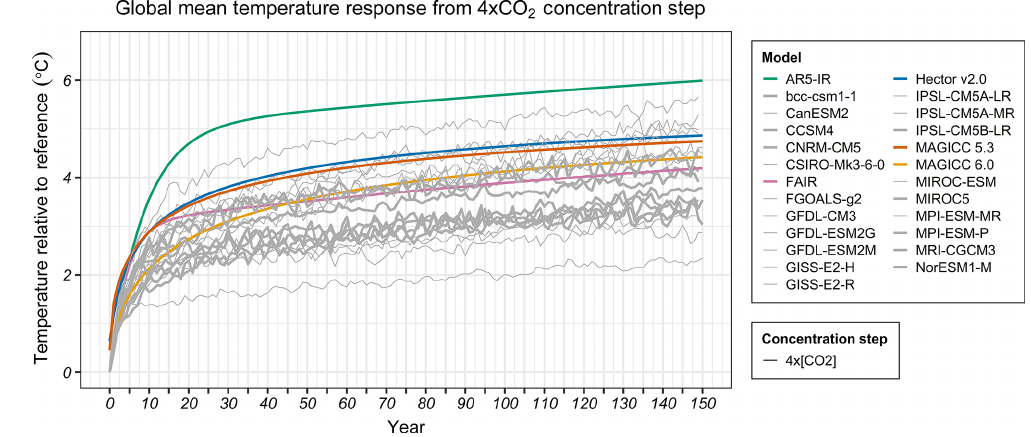
Figure 4. Global mean temperature response from 4 × CO 2 concentration step in CMIP5 models (grey) and SCMs (MAGICC 6.0 – yellow, MAGICC 5.3 BC–OC – red, Hector v2.0 – blue, FAIR – pink, AR5-IR – green). A climate sensitivity value of 3 ◦ C was used in the comprehensive SCMs, while in the idealized SCMs the parameter is not adjustable (see Sect. S2). The thick lines represent CMIP5 models with an ECS between 2.5 and 3.5 ◦ C. Table 1. Integrated temperature response differences. The values are the percent difference in time-integrated temperature response compared to the relevant reference (generally comprehensive SCM average; see Sect. S9). ∗ For BC specifically, we note that none of the SCMs reflect the temporal response for BC seen in two complex models (Sand et al., 2016; Yang et al., 2019; see Sect. S13). Species Impulse Time Percent integrated temperature response differences for each after simple climate model (%) pulse Hector MAGICC MAGICC FAIR AR5-IR v2.0 5.3 6.0 v1.0 4 × H = 100yr 38% 35% 15% 18% 73%forcing CO 2 Forcing H =